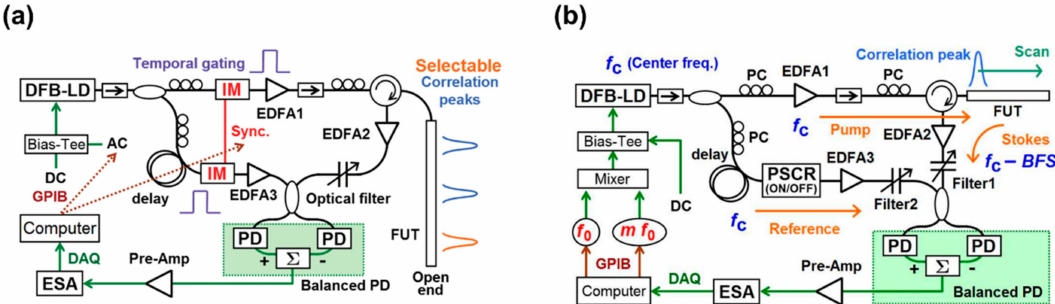
Figure 4. Special BOCDR configurations with extended measurement ranges. ( a ) Temporal gating scheme and ( b ) double modulation scheme. AC, alternating current; DAQ, data acquisition; DC, direct current; DFB-LD, distributed-feedback laser diode; EDFA, erbium-doped fiber amplifier; ESA, electrical spectrum analyzer; FUT, fiber under test; GPIB, general-purpose interface bus; IM, intensity modulator; PC, polarization controller; PD, photodiode; PSCR, polarization scrambler. [42,43]. Copyright (2009,2010)